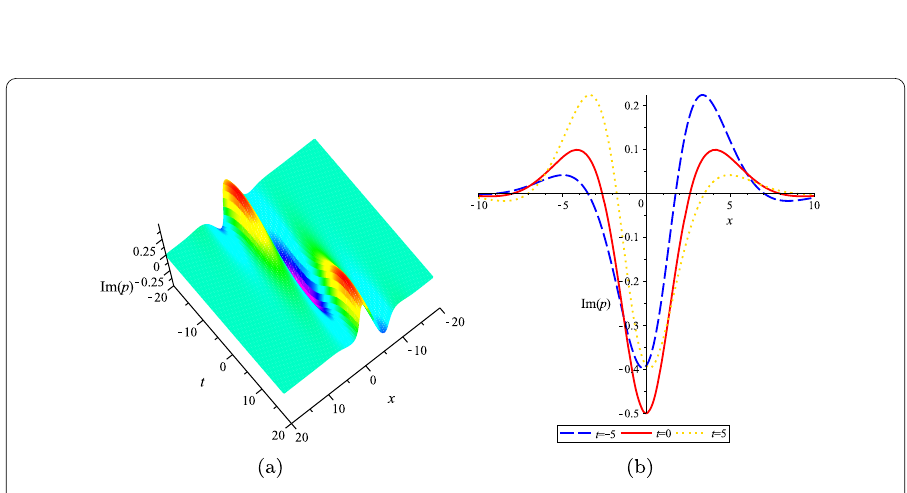
Figure 3 One-soliton solution (26) with ˜ a 1 = 0.3, ˜ b 1 = 0.25, α 1 = β 1 = 1, ξ 1 = 0. ( a ) Perspective view of the imaginary part of p ; ( b ) The soliton along the x -axis with different time in Fig.